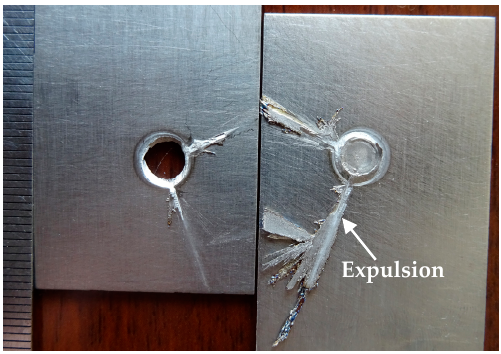
Figure 6. Expulsion at the faying surface between two metal sheets.